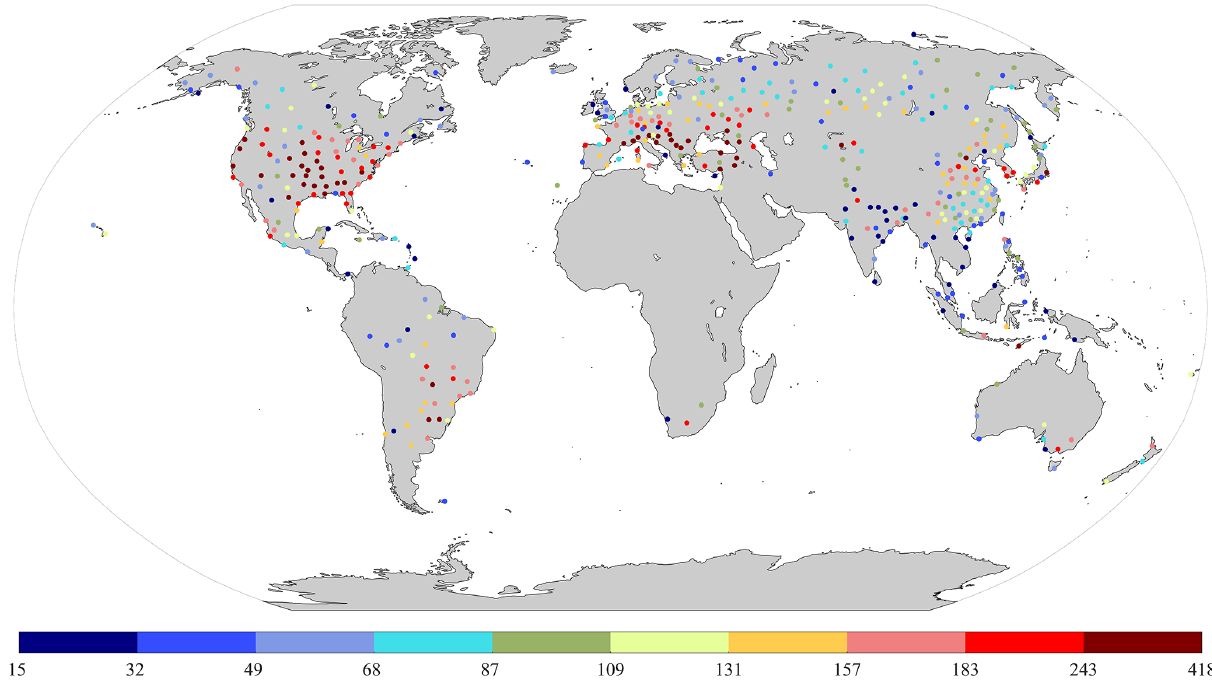
Figure 2. Number of matchups between MERSI-II and IGRA PWV observations for each site from 2018–2021.